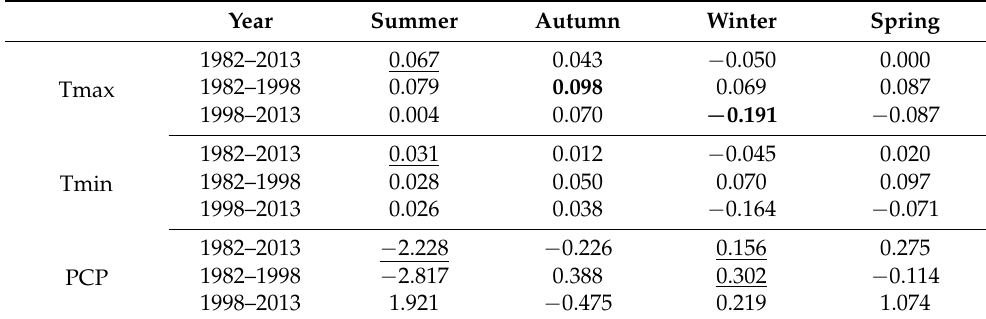
Table 1. Trend of climate factors in DNF.